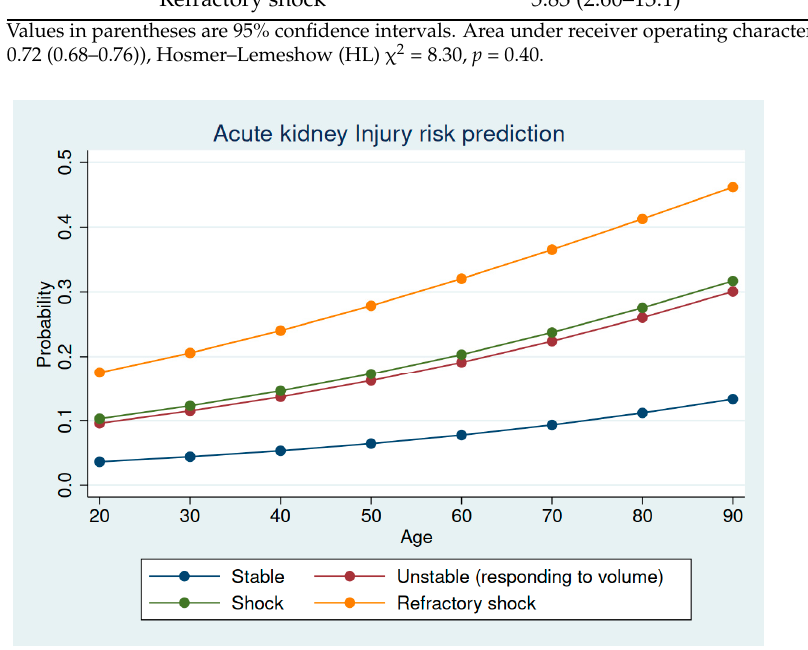
Figure 2. Risk of developing AKI according to age and the hemodynamic response. Table 3. The results of the logistic regression analysis aiming to identify risk factors associated with AKI.